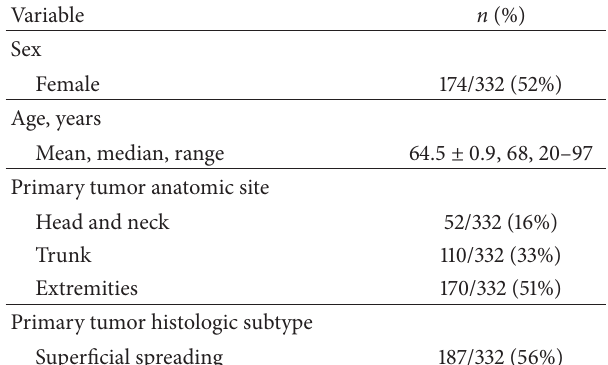
Table 1: Demographic and tumor features of 332 cutaneous melanoma patients.